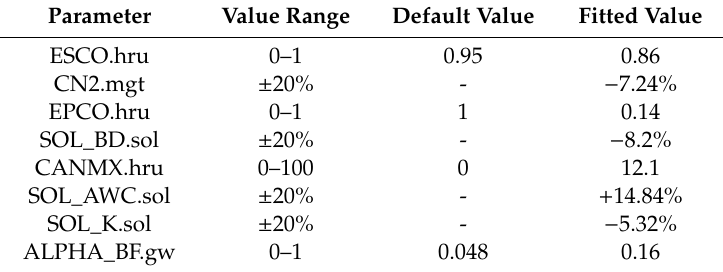
Table 5. Optimized SWAT parameters for calibration of AET.